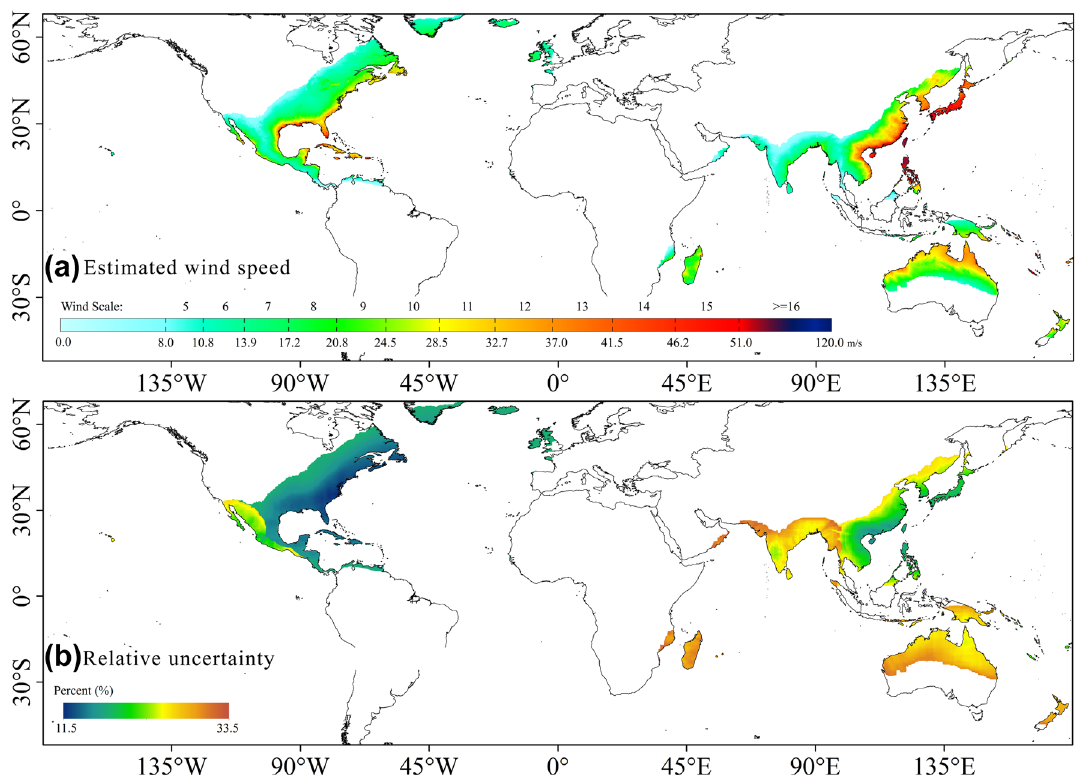
Fig. 9 Global TC wind hazard map at 1 km resolution (3-s gust winds for a 100-year return period) in seven ocean basins Fig. 10 Maximum difference (D) of the Kolmogorov– Smirnov (K–S) test for goodness-of-fit in tropical storm-impacted areas of seven ocean